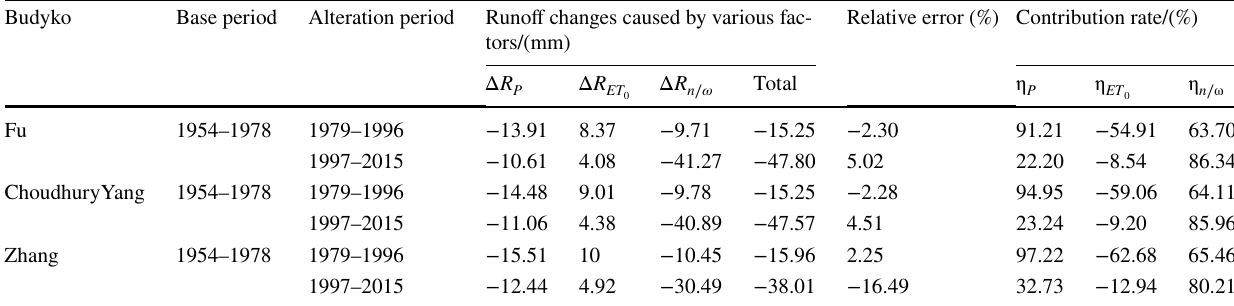
Table 5 Contribution rate of runoff variation in Huangfuchuan River basin calculated by total differential method